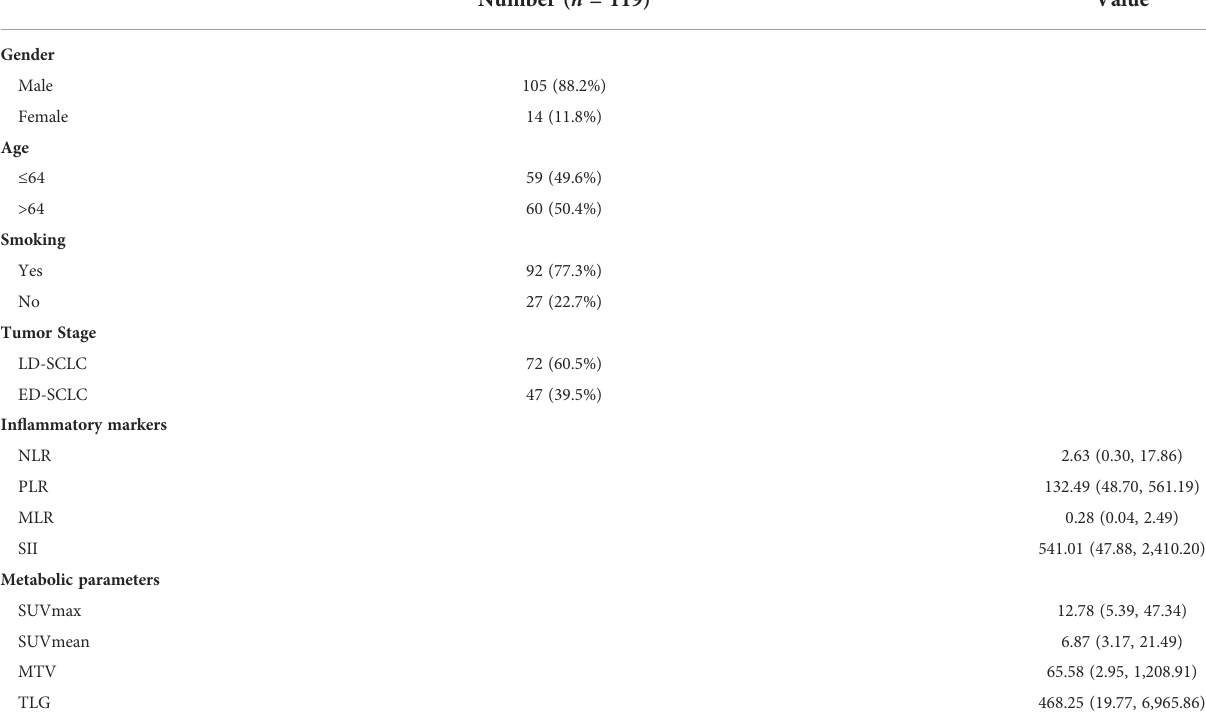
TABLE 1 Patient characteristics.